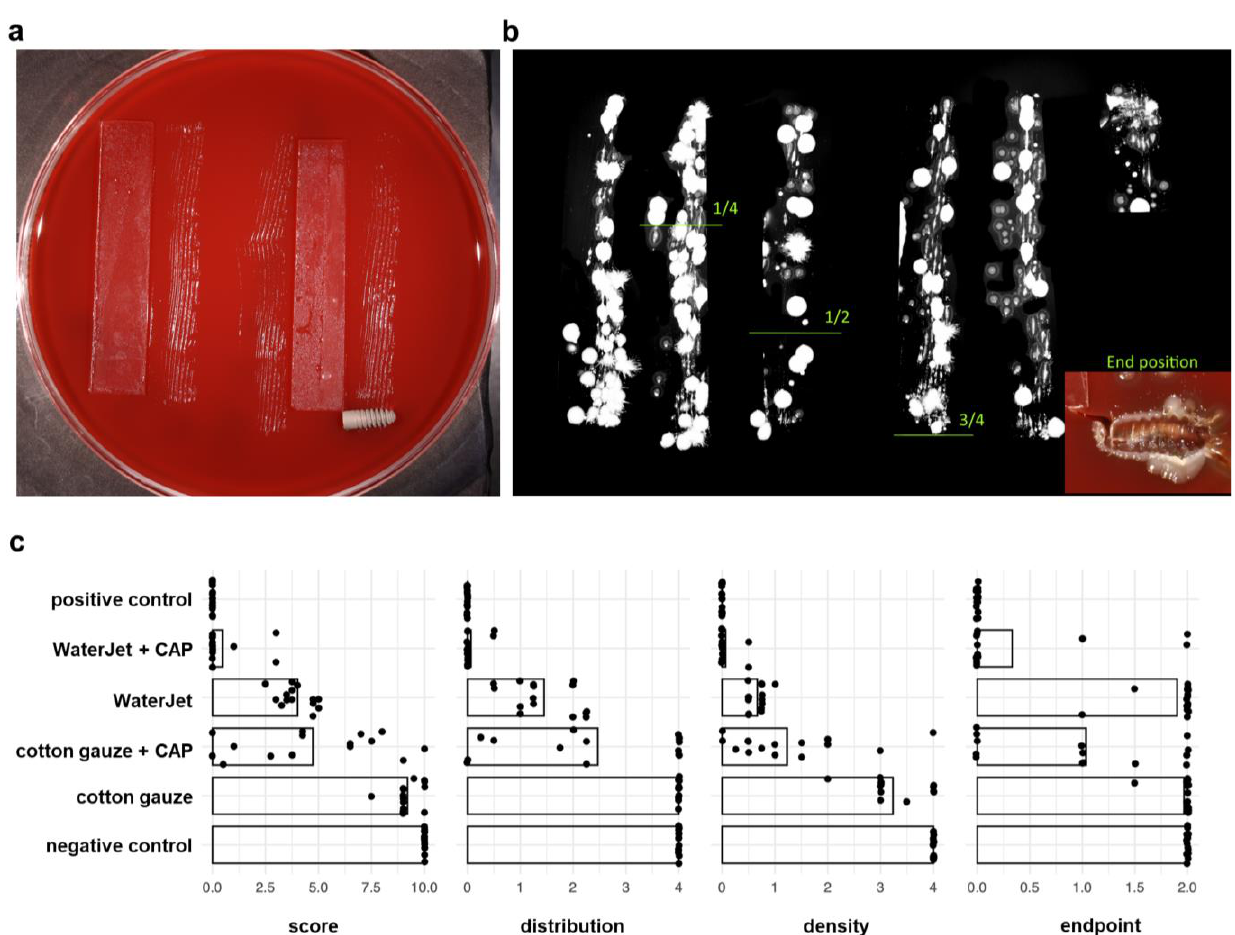
Figure 2. Antimicrobial efficacy. ( a ) scheme of the roll-out-on-agar method, where the implants were rolled on agar along glassware tracks for 30 cm; ( b ) agar plates were incubated for 72 h at 37 ◦ C, and digital images were scored, the gradient limits and the end position are shown; ( c ) score analysis of antimicrobial